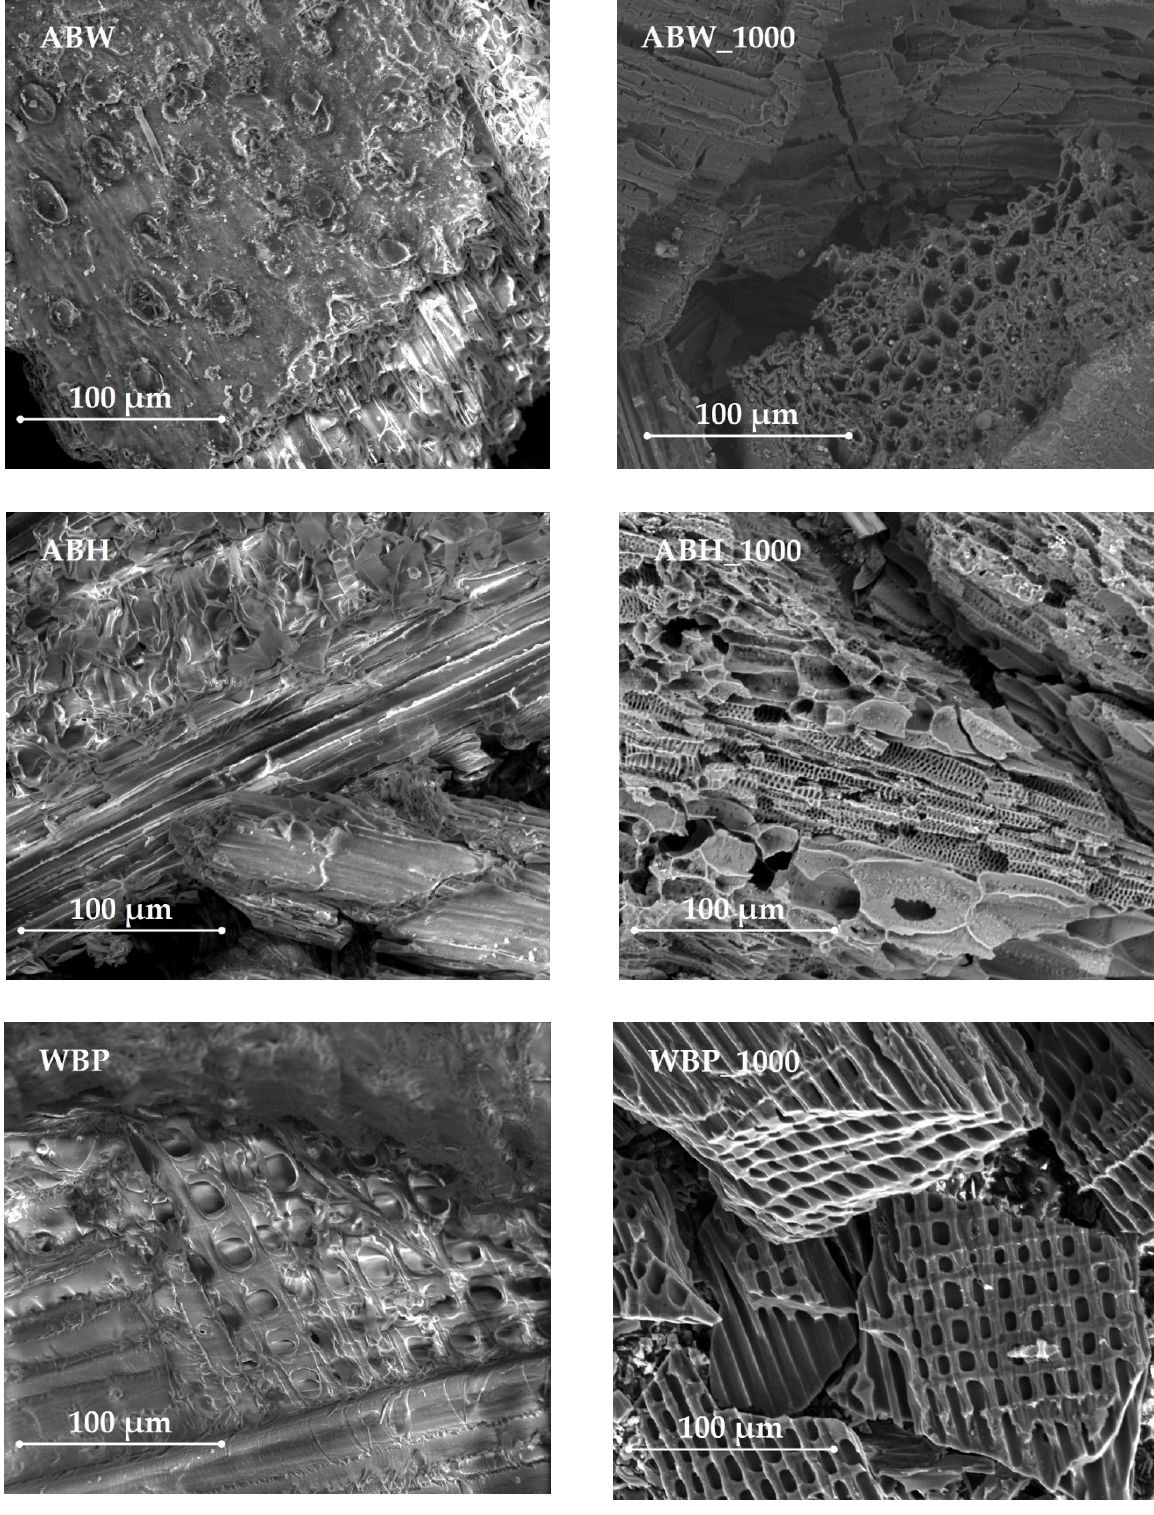
Figure 5. SEM images of the raw biomasses (ABW, ABH, and WBP) and their chars (ABW_1000, ABH_1000, and WBP_1000).